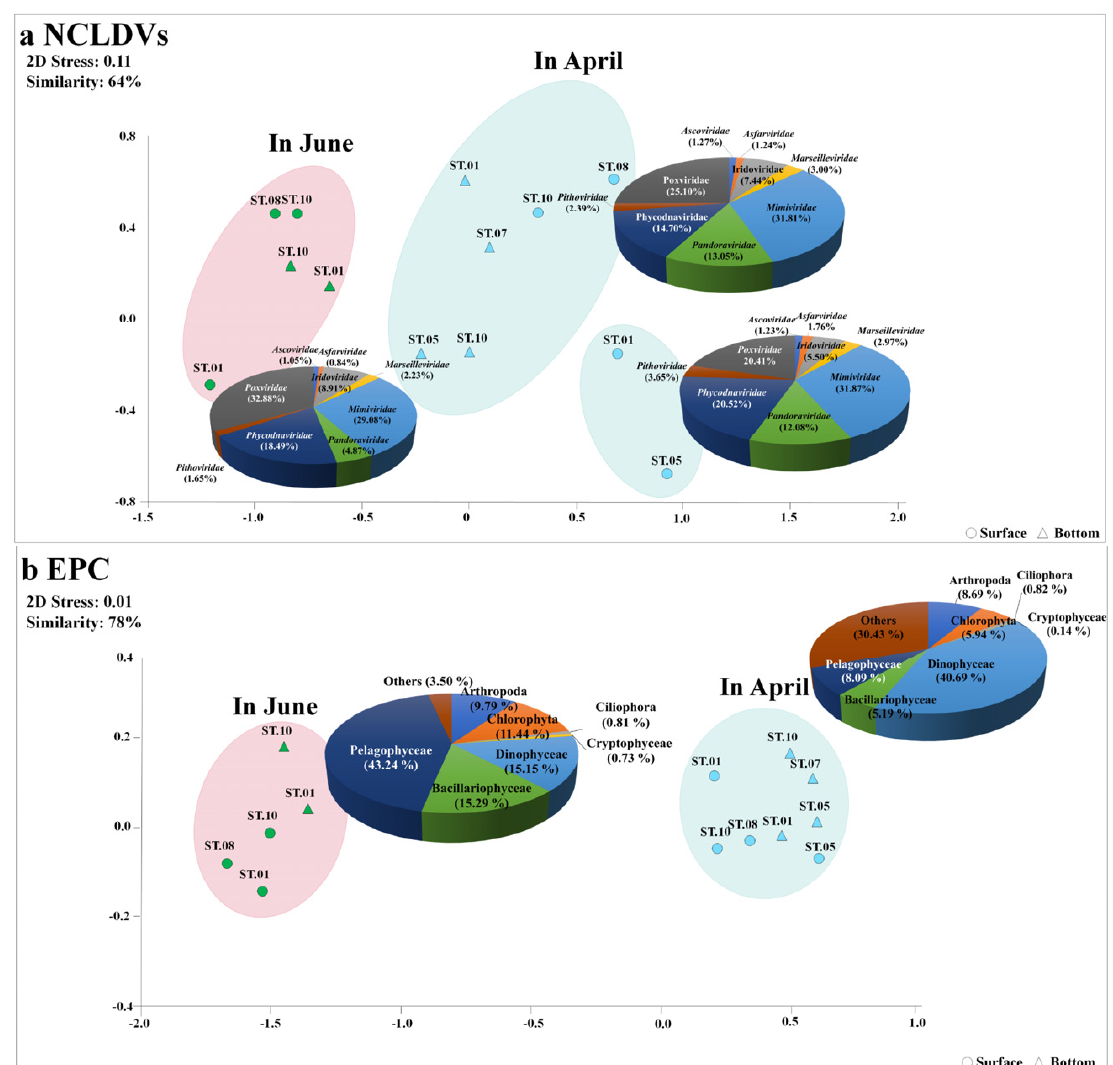
Figure 3. Non–metric multidimensional scaling (NMDS) plot in nucleocytoplasmic large DNA viruses (NCLDVs) ( a ) and the eukaryotic plankton community (EPC) ( b ) in the Sub–Arctic Kongsfjorden in April and June 2018. A total of eight sites were investigated during the cruises. The NMDS plot was analyzed using the Bray–Curtis dissimilarity method. All data were normalized by the fourth roots. The pie charts indicate the high–ranking taxonomic distribution at the family level for NCLDVs and the phylum (or class) level for the EPC.